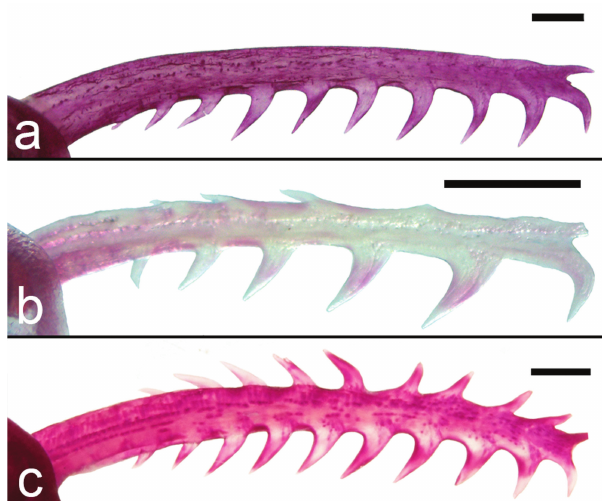
Fig. 2. Right pectoral-fin spines of cleared and stained specimens, in dorsal view. a. Adult specimen of Bunocephalus hartti , MNRJ 31385, 42.2 mm SL. b. Juvenile specimen of Bunocephalus hartti , MCP 48280, 21.5 mm SL. c. Adult specimen of Bunocephalus minerim , MCP 28379, paratype, 48.4 mm SL. Scale bar 1 mm.